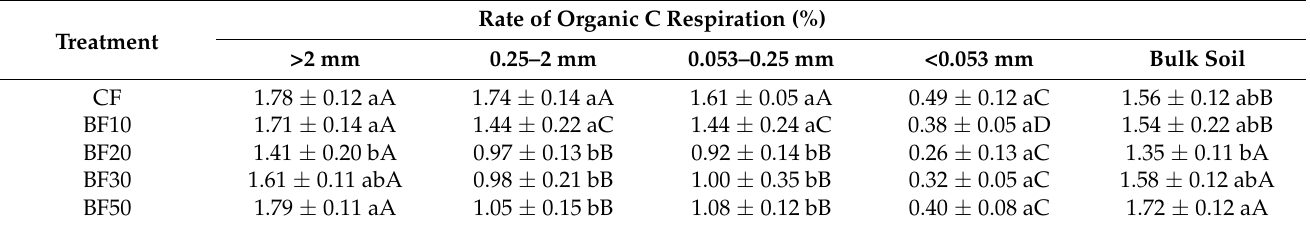
Figure 3. Cumulative mineralization of organic C in different aggregate fractions ( a ) and bulk soil ( b ) under the five treatments. Different lowercase letters indicate significant differences among treatments at p < 0.05. CF, BF10, BF20, BF30 and BF50 are defined as in Figure 1. Table 2. The rate of organic C respiration in the four aggregate fractions and bulk soil.